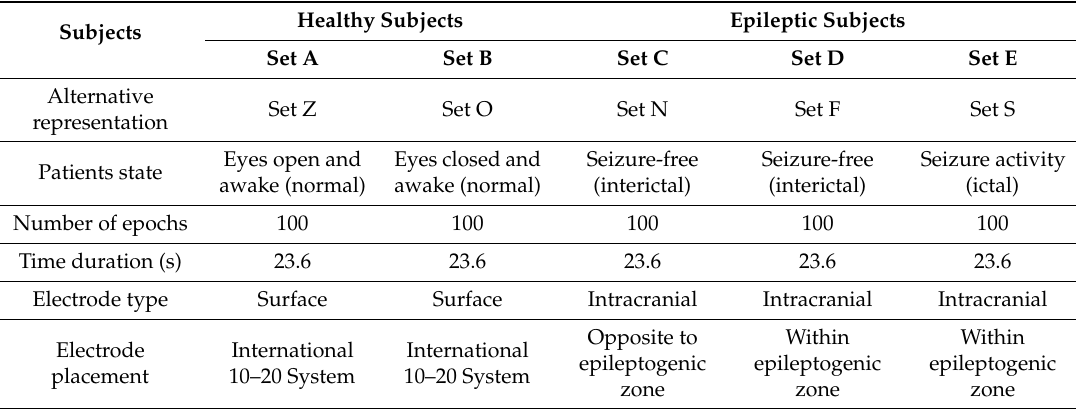
Table 1. Summary of the electroencephalography (EEG) dataset used in this